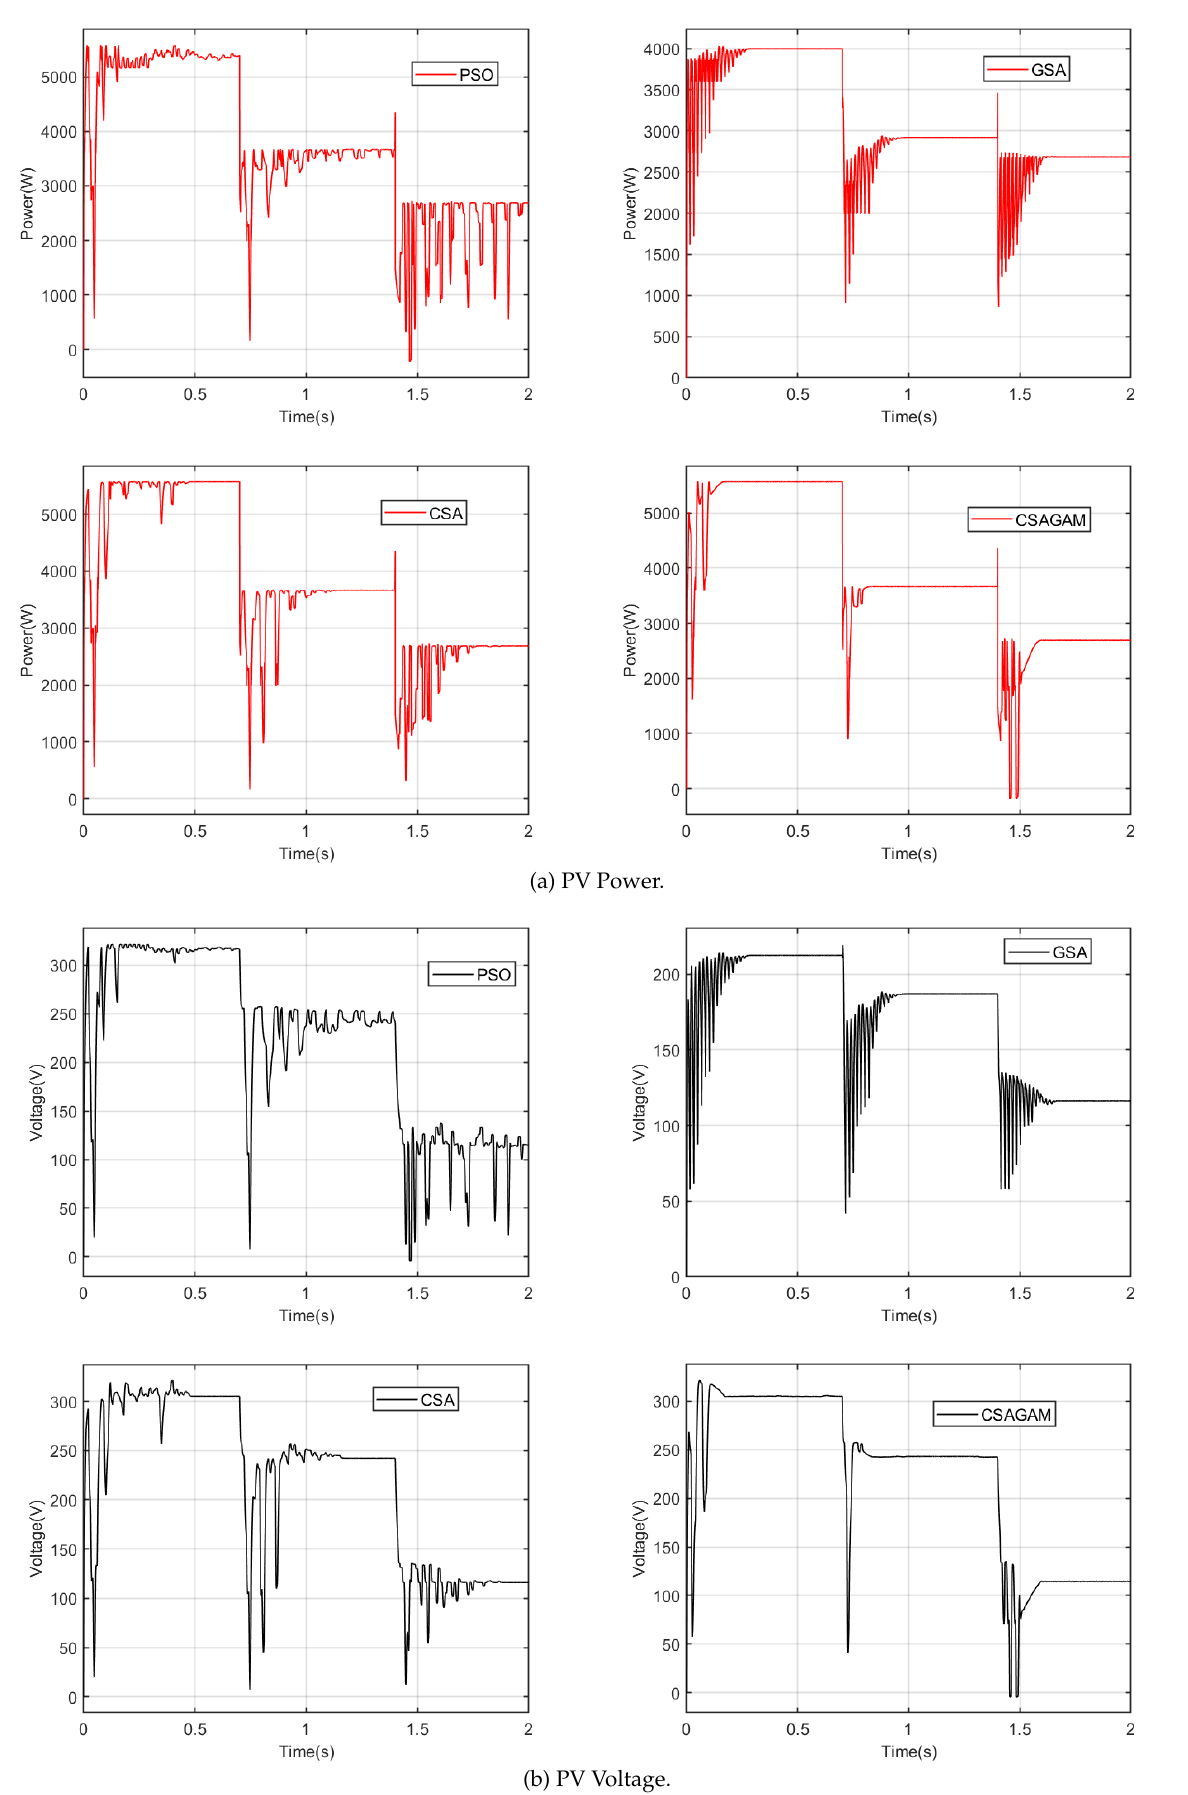
Fig. 9. Simulation results for the changing partial shading PSC 1-PSC 2-PSC